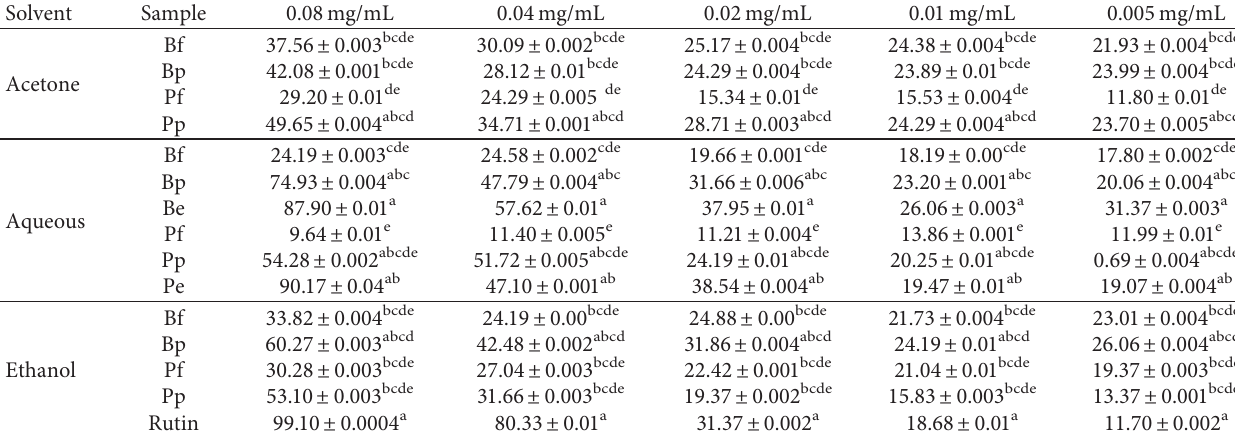
Table 5: ABTS radical inhibition activity (%) by extracts and